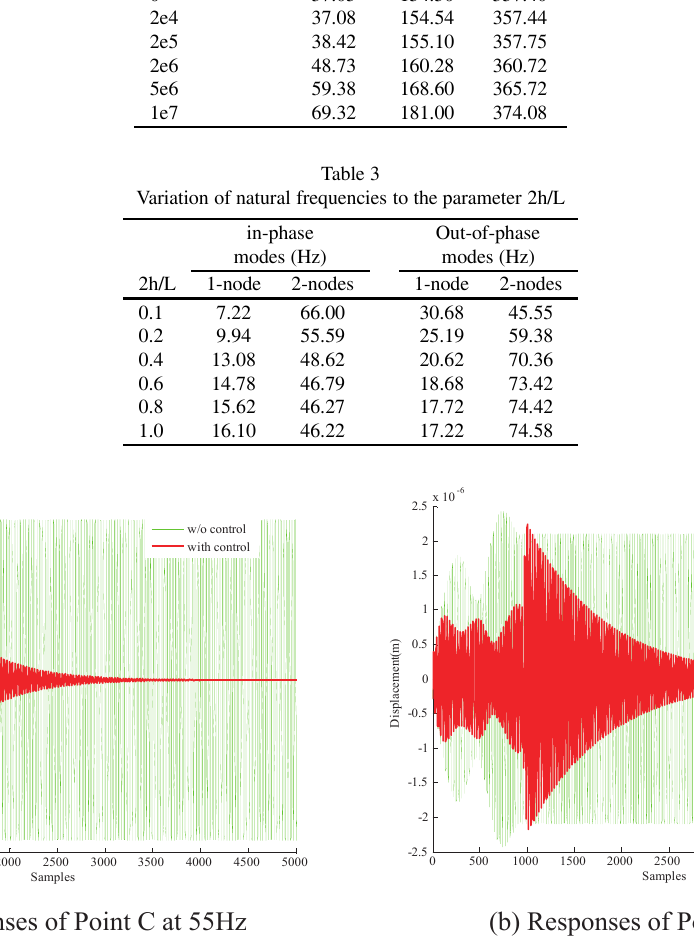
Fig. 8. Controlled vibration of